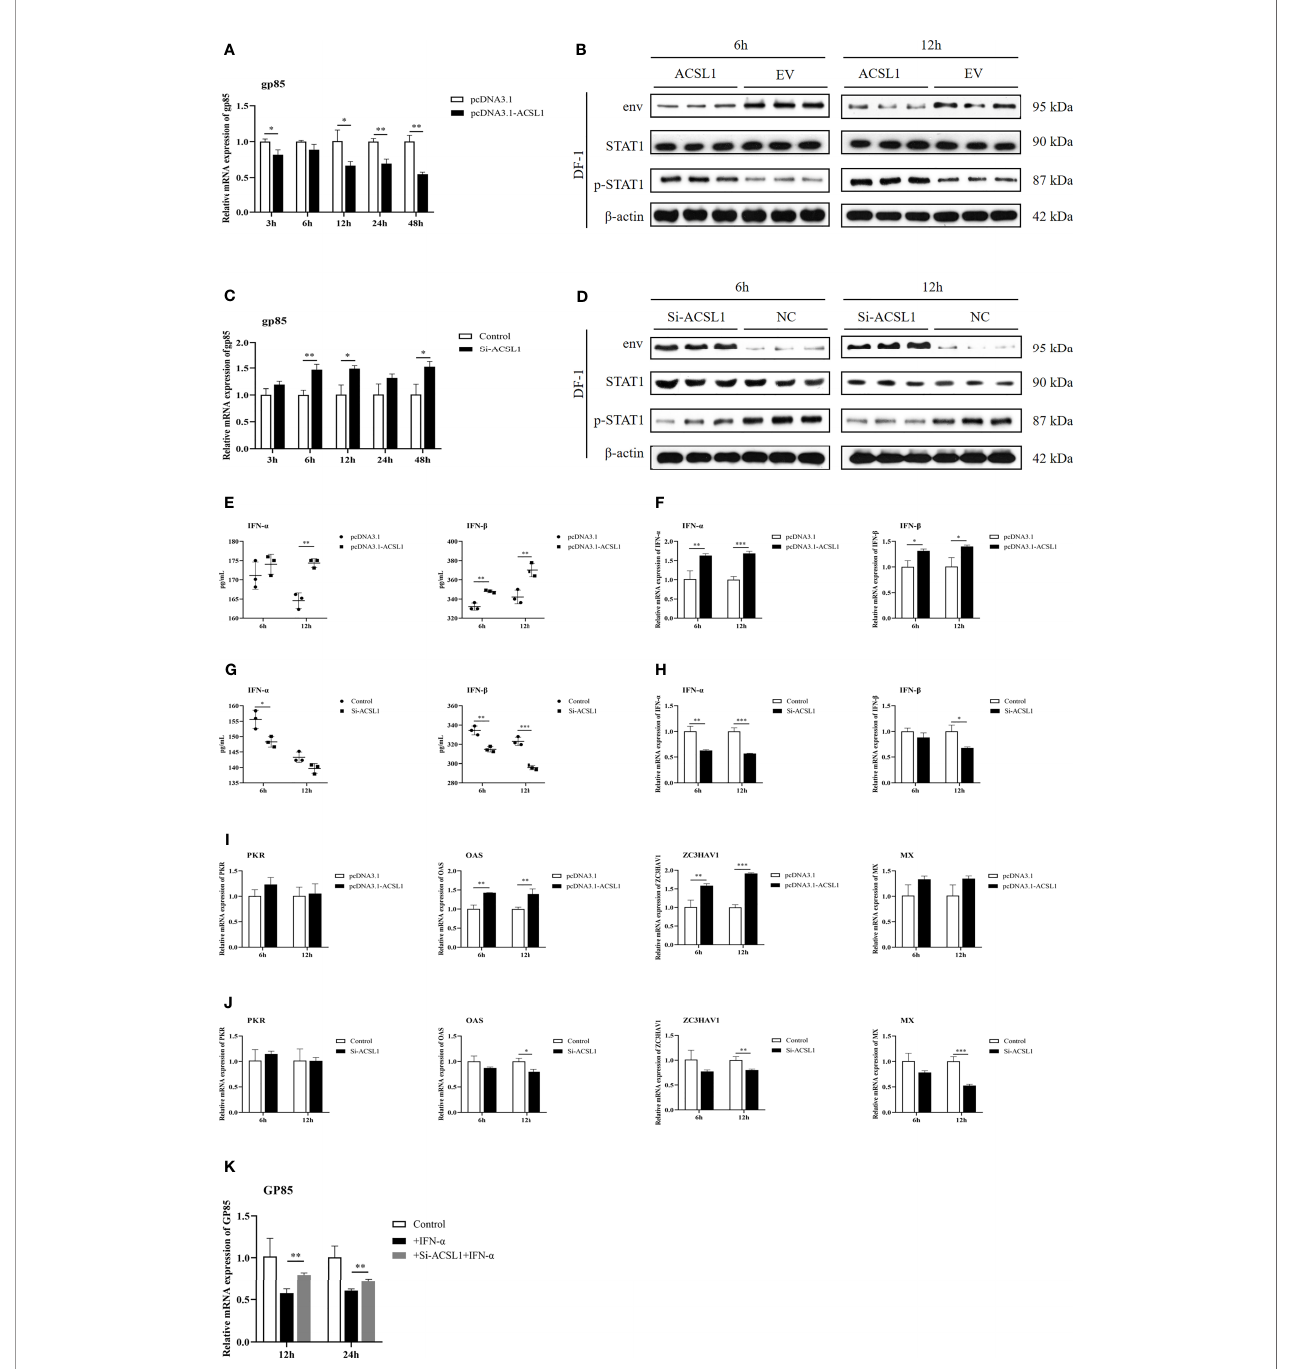
FIGURE 2 | ACSL1 inhibited ALV-J replication by enhancing IFN-I production. (A, C) ACSL1 overexpression (A) and knockdown (C) in DF-1cells for 48 h and then infected with ALV-J (10 4 TCID 50 /0.1 ml). Relative mRNA levels of gp85 were determined by qRT-PCR for the indicated time. (B, D) ACSL1 overexpression and knockdown in DF-1 cells for 48 h and then infected with ALV-J (10 4 TCID 50 /0.1 ml) for 6 and 12 h before assays. Immunoblot analysis of the levels of ALV-J envelope protein JE9 (env), STAT1, and p-STA1 from ACSL1 overexpression cells (B) or ACSL1 knockdown cells (D) . (E, F) The levels of IFN- a /IFN- b were determined by qRT- PCR (E) and ELISA (F) from ACSL1 overexpression cells. (G, H) qRT-PCR (G) and ELISA (H) analysis of the expression levels of IFN- a /IFN- b from ACSL1 knockdown cells. (I, J) qRT-PCR analysis of the expression levels of ISGs, including PKR, OAS, ZC3HAV1, and Mx from ACSL1 overexpression (I) or knockdown cells (J) . (K) DF-1 cells were transfected with small interfering RNA (siACSL1 or si-control) for 48 h prior to treatment with IFN- a (1,000 U/ml) for 1 h and then infected with ALV-J (10 4 TCID 50 /0.1 ml). qRT-PCR analysis of gp85 level for the indicated time. Data shown are the means±SEM (n=3). P values were calculated using two-tailed unpaired Student ’ t-test. Differences with P<0.05 were considered signi fi cant. *P < 0.05, **P < 0.01, ***P <